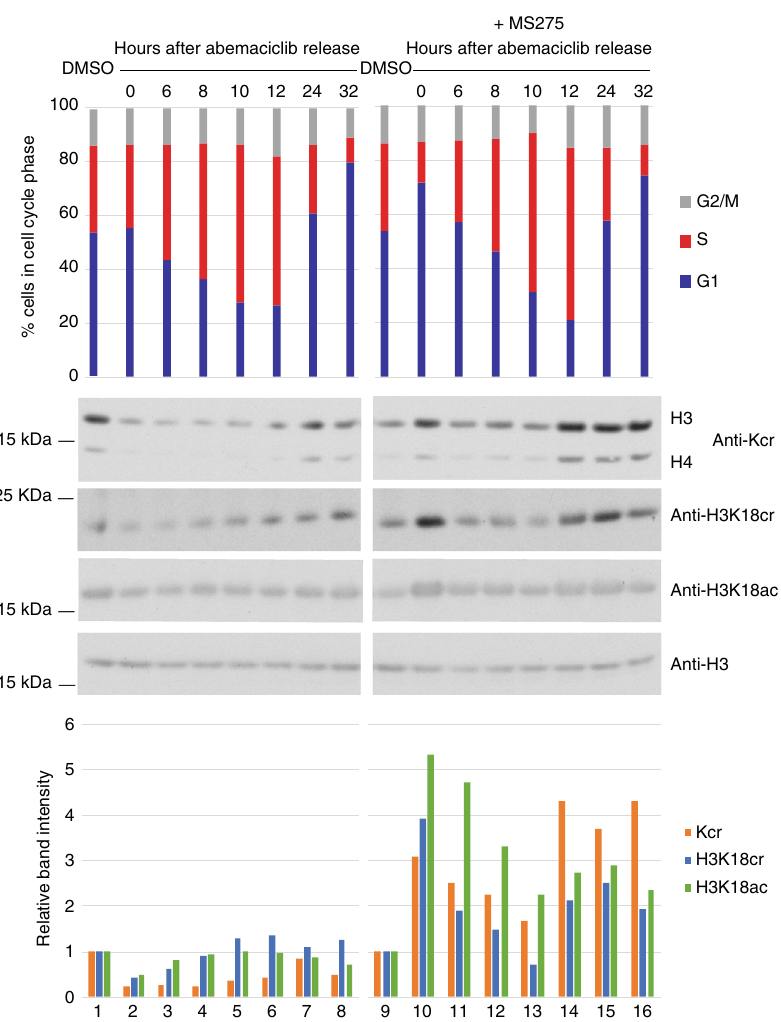
Fig. 6 Histone crotonylation is cell cycle regulated by class I HDACs. Cell cycle block and release experiment on HCT116 cells using CDK4/6 inhibitor abemaciclib with and without MS275. Lanes 1 and 9: asynchronous cells, lane 2: G1 arrested cells, lanes 3 – 8: increase in histone crotonylation (Kcr), H3K18cr and H3K18ac upon release into S phase. Lanes 10 – 16: histone crotonylation, H3K18cr and H3K18ac are upregulated during a G1 arrest and S phase when class I HDACs are inhibited with MS275. For the experiments in lanes 9 – 16, cells were blocked in G1 using 15 nM abemaciclib in the presence of 5 μ M MS275 and released into S phase in the presence of 1 μ M MS275. Cell cycle pro fi les are shown at the top, western blots in the middle, and quanti fi